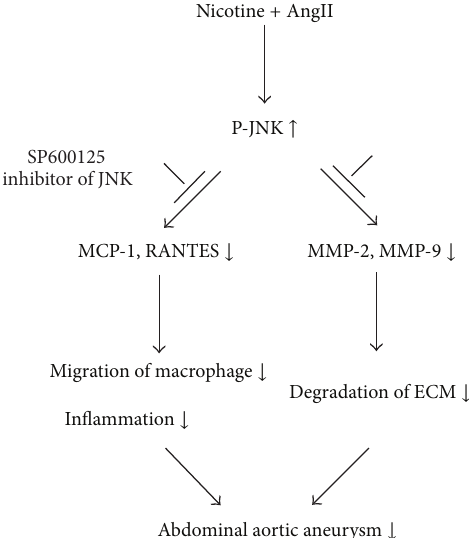
Figure 1: Proposed mechanism of SP600125-mediated suppression of nicotine-related AAA in the C57BL/6J mouse model. AngII, angiotensin II; JNK, c-Jun N-terminal kinase; MCP-1, monocyte chemoattractant protein-1; RANTES, regulated-on-activation, nor- mal T-cell expressed and secreted; MMP, matrix metalloproteinase; ECM, extracellular